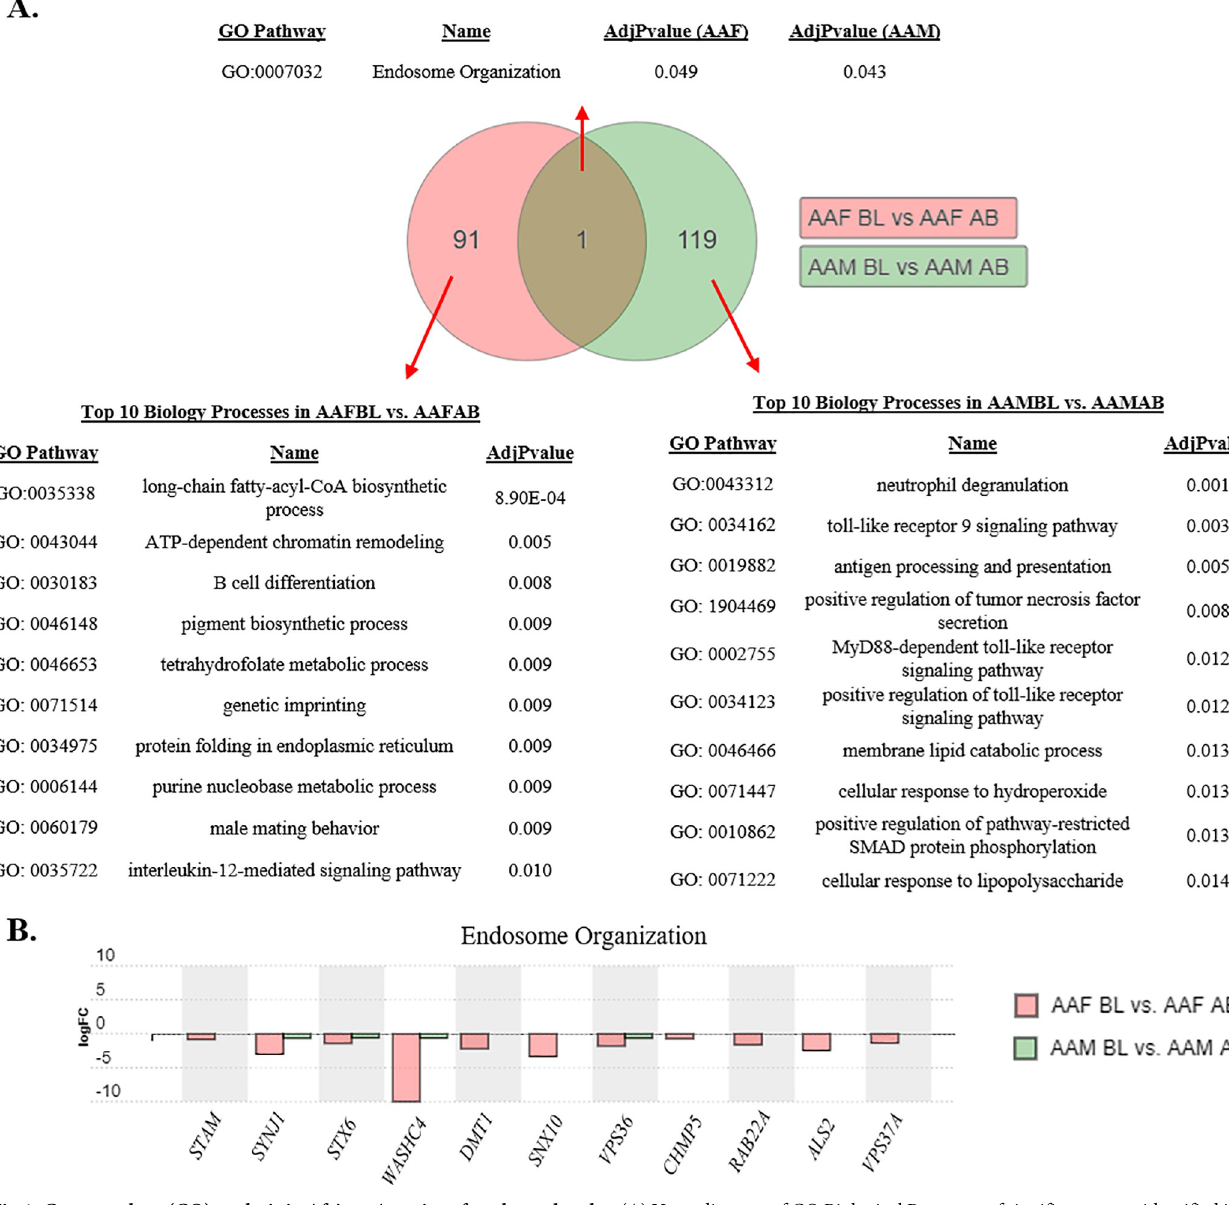
Fig 4. Gene ontology (GO) analysis in African American females and males. (A) Venn diagram of GO Biological Processes of significant genes identified in AAFBL vs. AAFAB compared with AAMBL vs. AAMAB. Unique and common pathways for each comparison of poverty status in females (pink) and males (green) were identified after elimination pruning P-value adjustment to eliminate false positives. Tables provide Top 10 Biological Processes unique to AA females or AA males or overlapping between both groups. Pathways are reported with GO ascension number, name, and adjusted P-value (AdjPvalue). (B) Differential expression of significant genes identified common Endosome Organization pathway. Gene expression is reported as logFC in AAFBL vs. AAFAB (pink) or AAMBL vs. AAMAB (green).